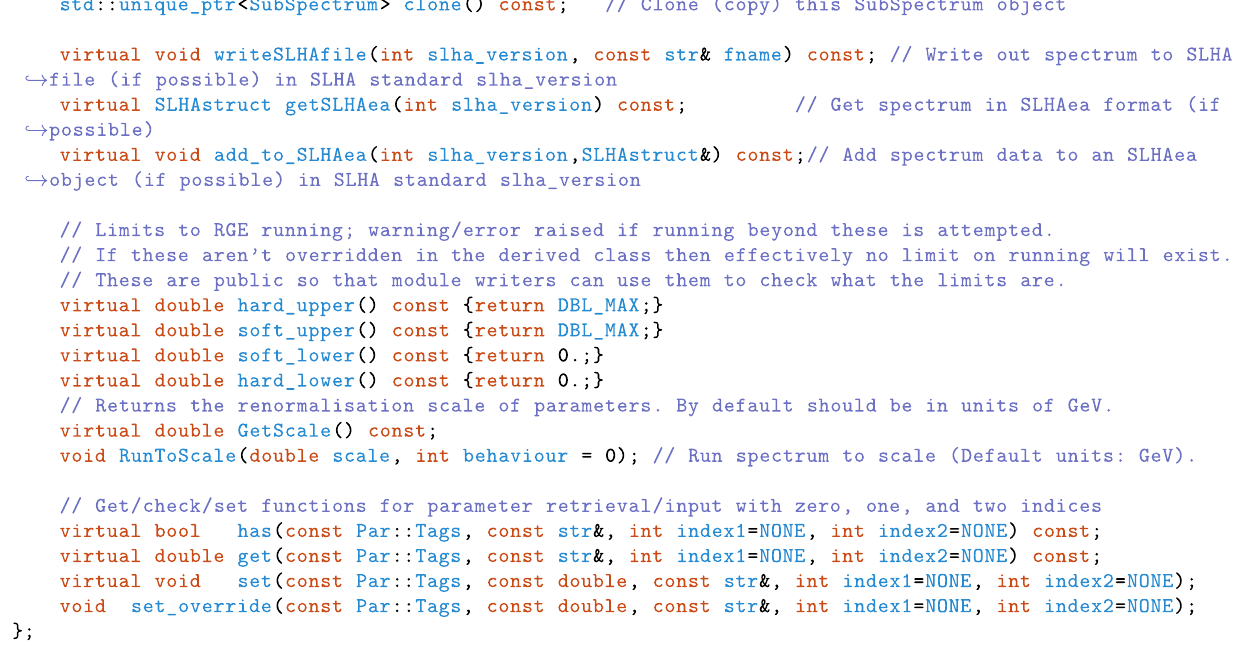
tions are implemented via operator overloads rather than the optional arguments shown. For the full class definition please see Elements/include/gambit/Elements/subspectrum. hpp in the GAMBIT source